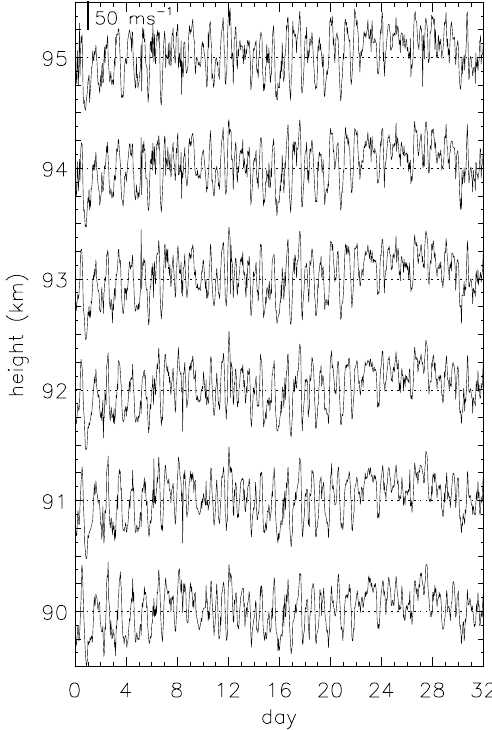
Fig. 1. Meridional wind at the heights of 90–95km for 32 days from 10 November to 11 December